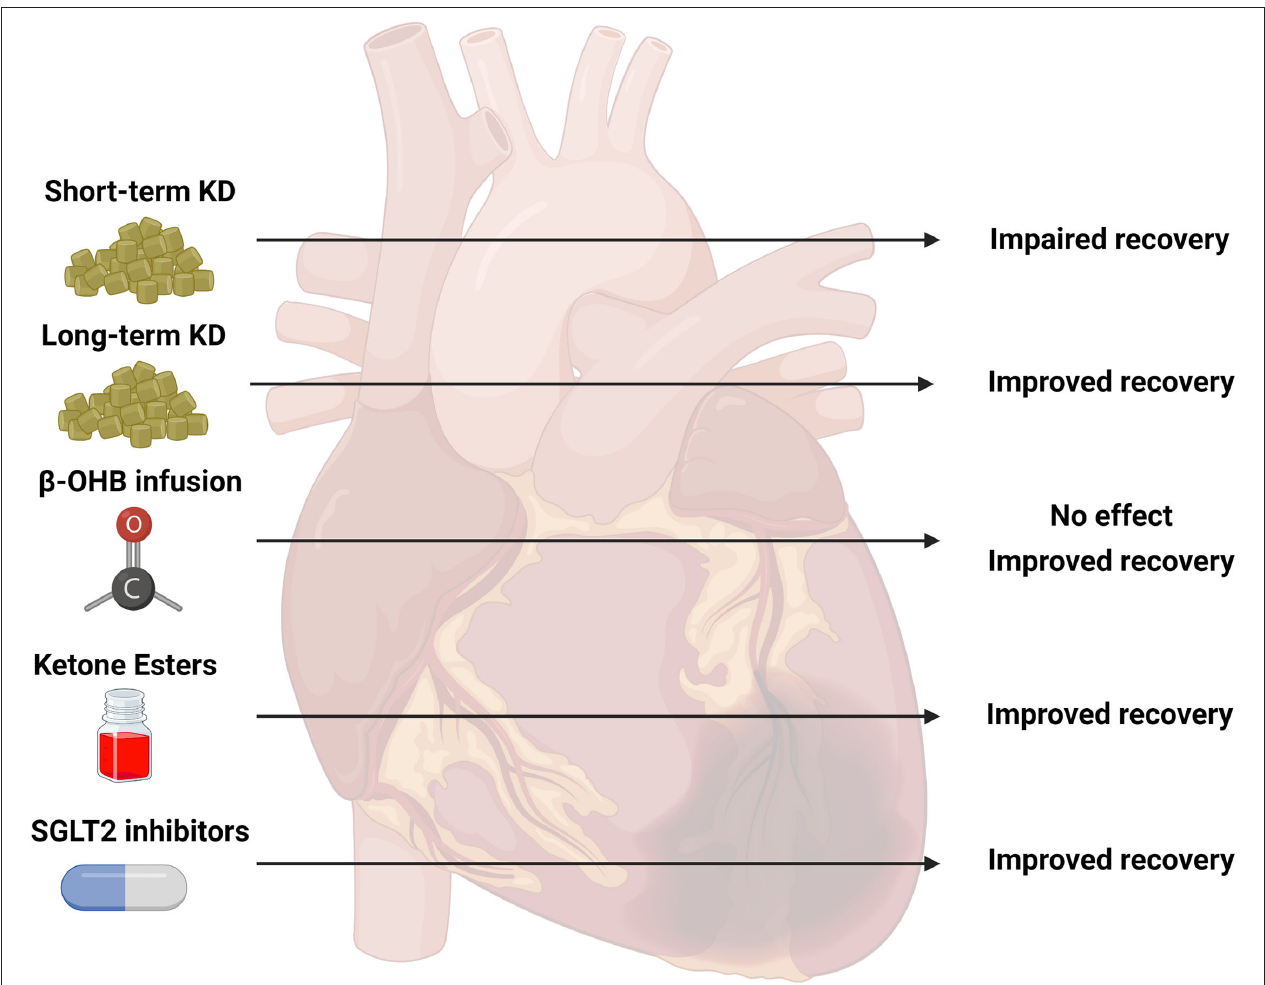
FIGURE 2 | Summary of studies investigating ketone body metabolism in the ischemic heart. Various strategies to target ketone body metabolism in models of cardiac ischemia have been attempted including short-term ketogenic diets (KD, 2–4 weeks), long-term KD (19 weeks), infusion of beta-hydroxybutyrate ( β -OHB), ketone ester (KE) supplementation, and sodium-glucose co-transporter 2 (SGLT2) inhibitors. The observed outcomes of these various interventions are presented as impaired, improved, or no effect. The current literature is limited on the effectiveness of these specific strategies: short-term KD (five studies), long-term KD (1 study), β -OHB infusion (four studies), KE supplementation (1 study), SGLT2 inhibitors (three studies). Created with BioRender.com.